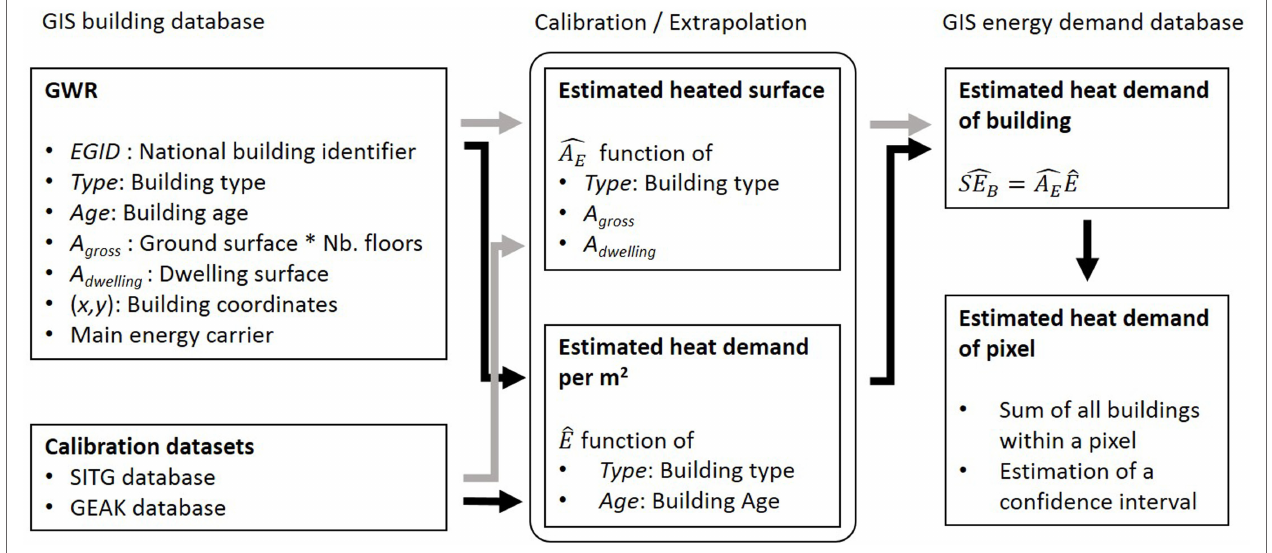
FIGURE 1 | Heat demand model